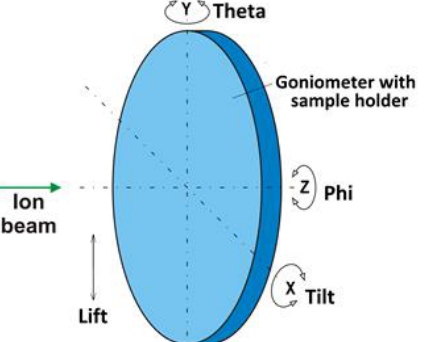
Figure 5. Principle arrangement of the 4D goniometer. Table 1. Notations.